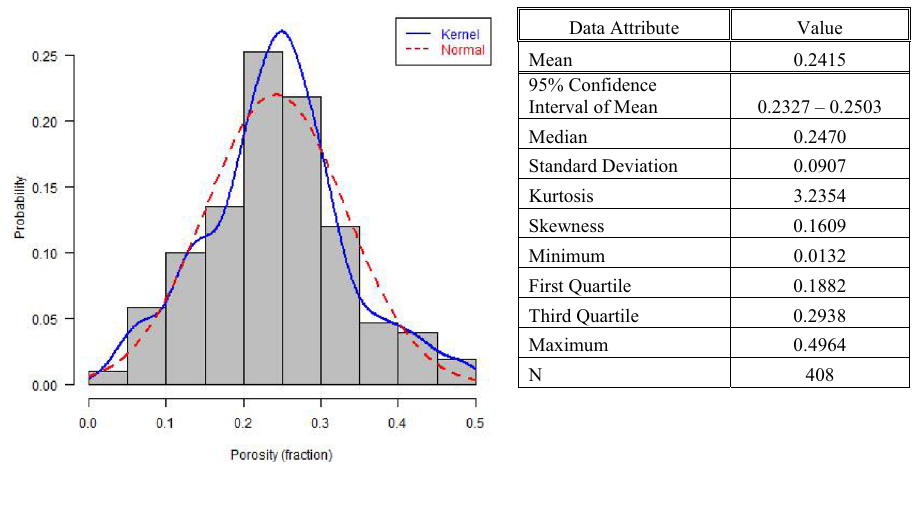
Fig. 5 Descriptive statistics and distributions of well-mean porosity